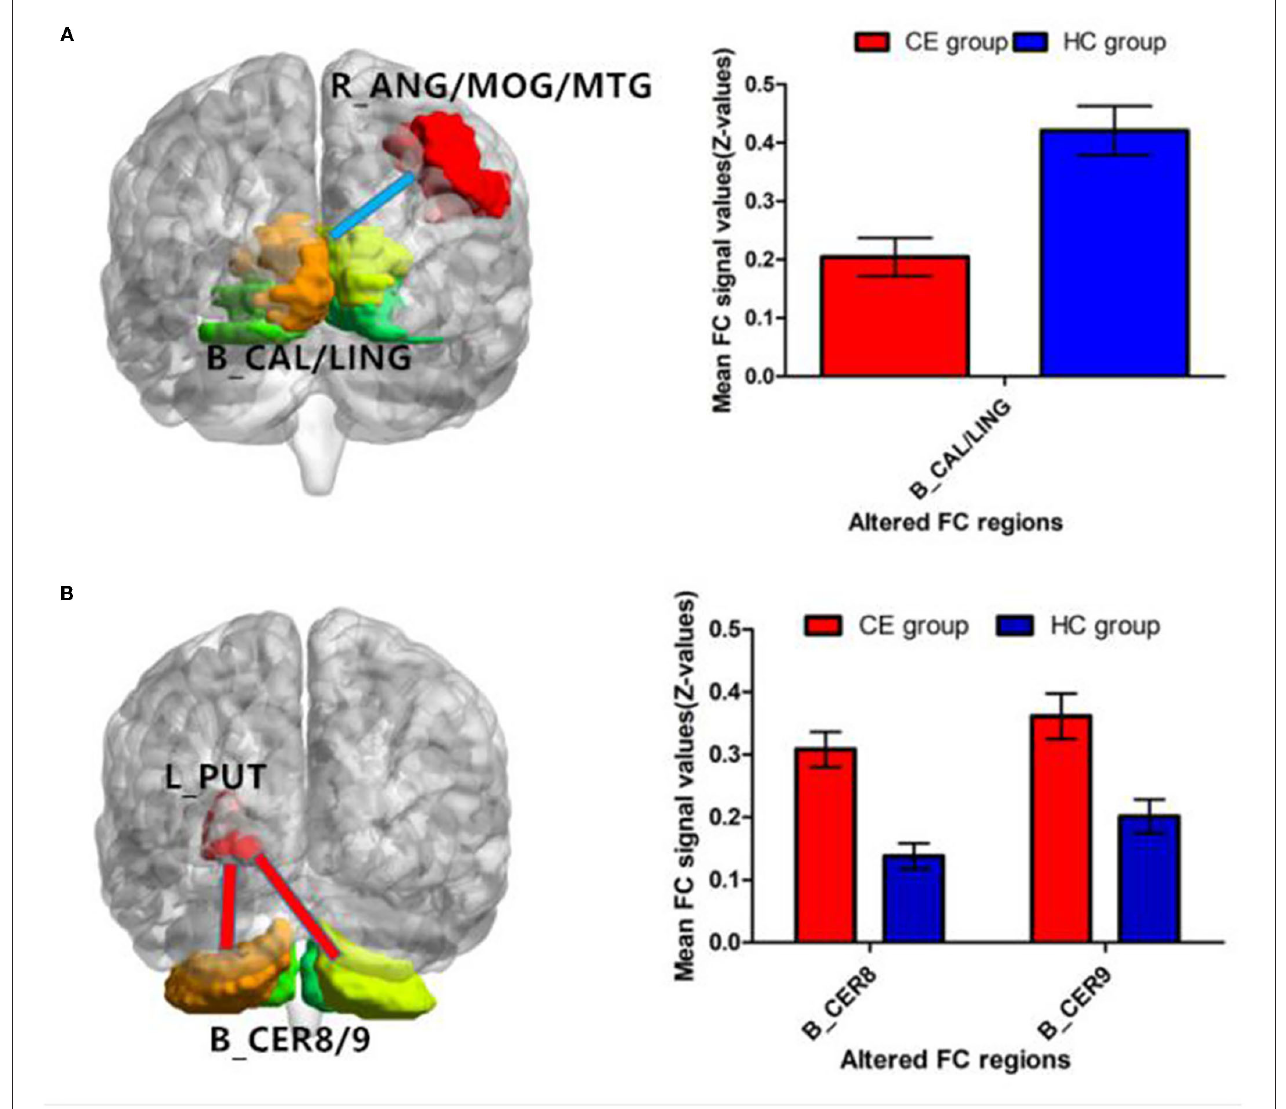
FIGURE 3 | Significant z-FC map differences seeded as ROI in different ALFF/fALFF regions between the two groups. The cool color indicates decreased z-FC values. The warm color indicates increased z-FC values. Significantly different FC values seeded as ROI in R-ANG/MOG/MTG (A) and L-PUT (B) . ALFF, amplitude of low-frequency fluctuation; fALFF, fractional amplitude of low-frequency fluctuation; ROI, region of interests; FC, functional connectivity; CE, comitant exotropia; HC, healthy control; ANG, angular; MOG, middle occipital gyrus; MTG, middle temporal gyrus; CAL, calcarine; LING, lingual; PUT, putamen; CER,